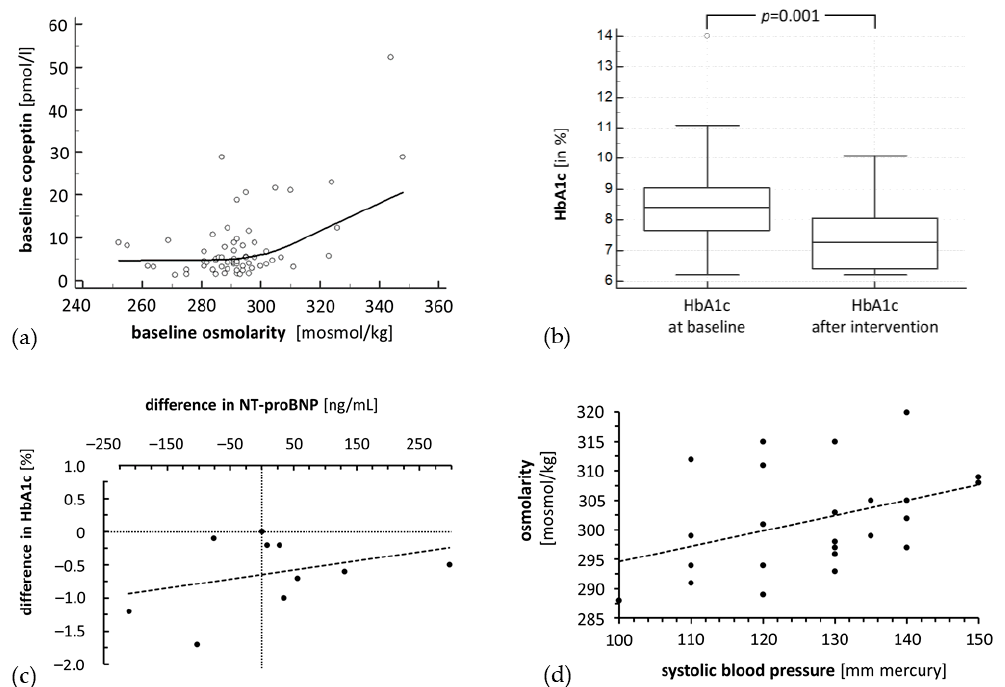
Figure 2. The ZEuS/oGTT study (arm A) showed that there is a significant correlation between baseline osmolality and copeptin concentrations ( a ). Patient education and changes in insulin treatment regiments reduced HbA1c values significantly in the ZEuS/DM study (arm B) of 24 patients with diabetes mellitus ( b ). In 10 of these patients, serum NT-proBNP concentrations were available and shown to rather increase with intensification of insulin therapy but remained lower the more HbA1c values dropped ( c ), negative figures indicate a smaller difference between pre- and postinterventional values. Plasma osmolality correlated with systolic blood pressure values ( d ).